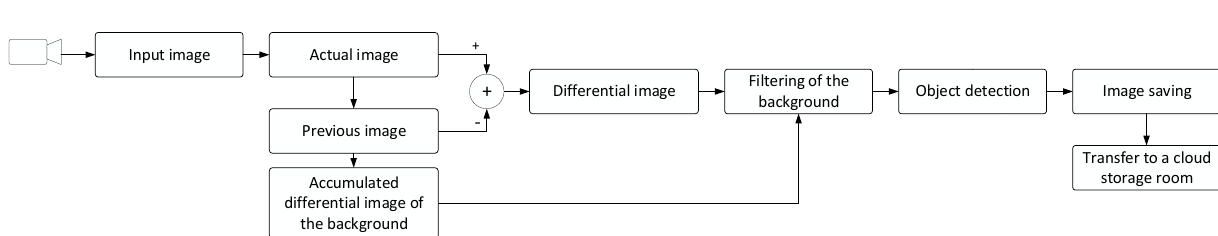
Figure 4. A flow chart characterizing the differential method (the input, actual, previous, and accumulated images); the differential image of the background; the differential image; the filtering of the background; object detection; image storage; transfer to a cloud storage room.